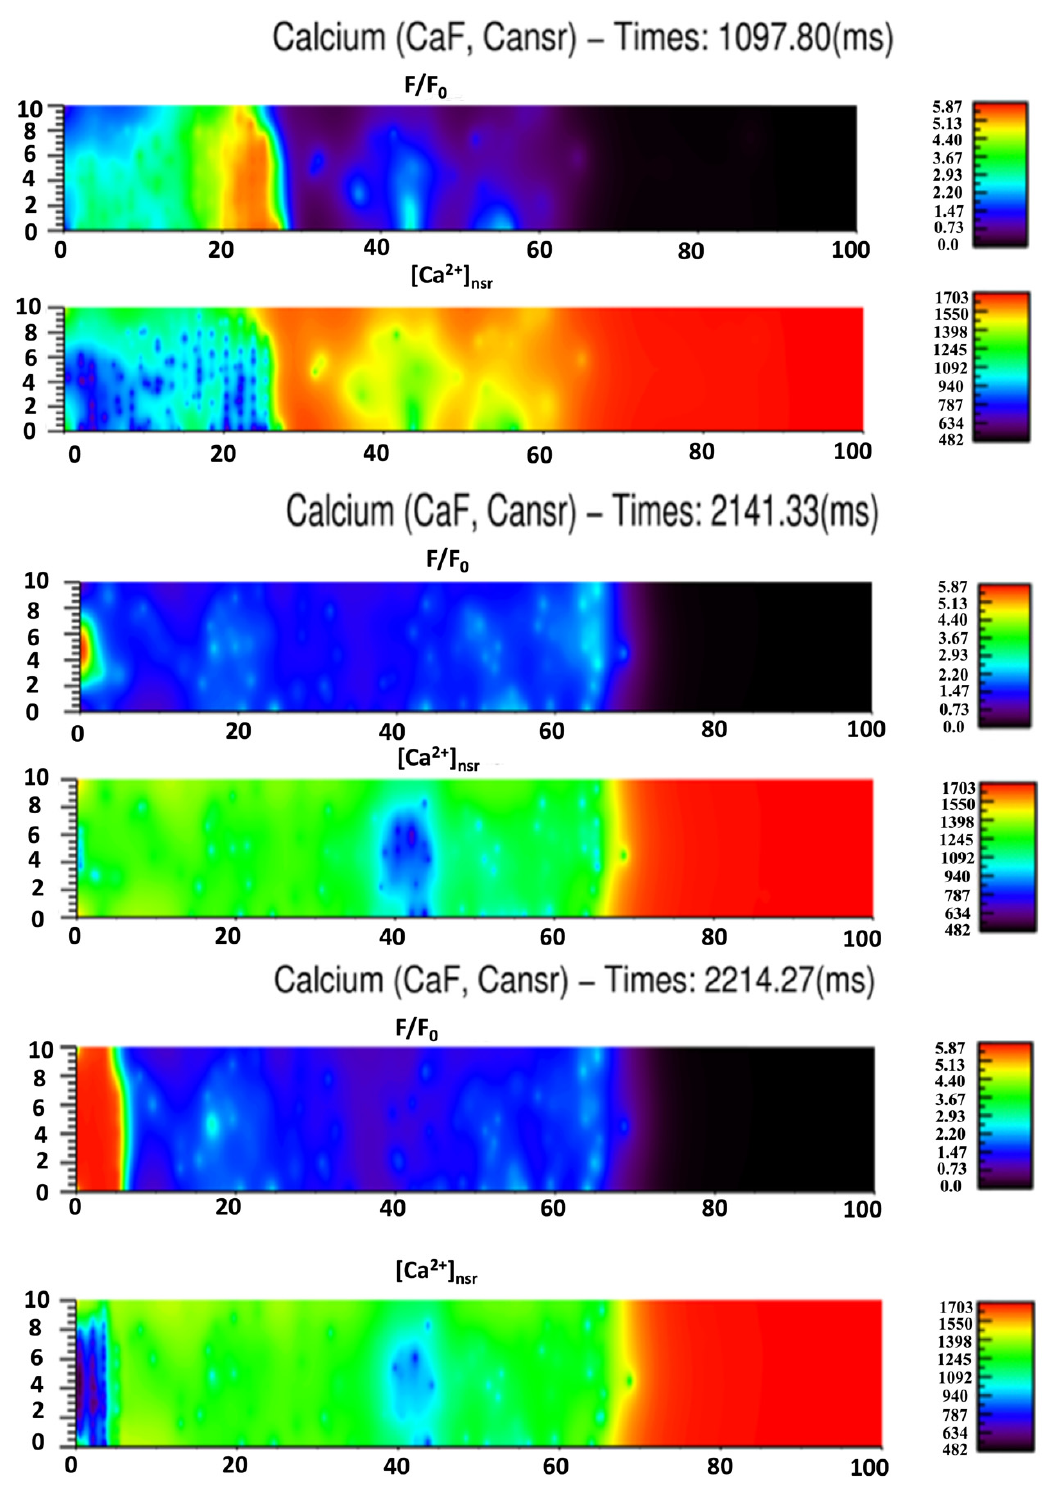
Figure 13. Given the initial [Ca] nsr = 1.7 mM, to derive the triggering of the wave, the simulation suggested that an overload of 1.5 mM is enough to trigger the repetitive calcium waves.